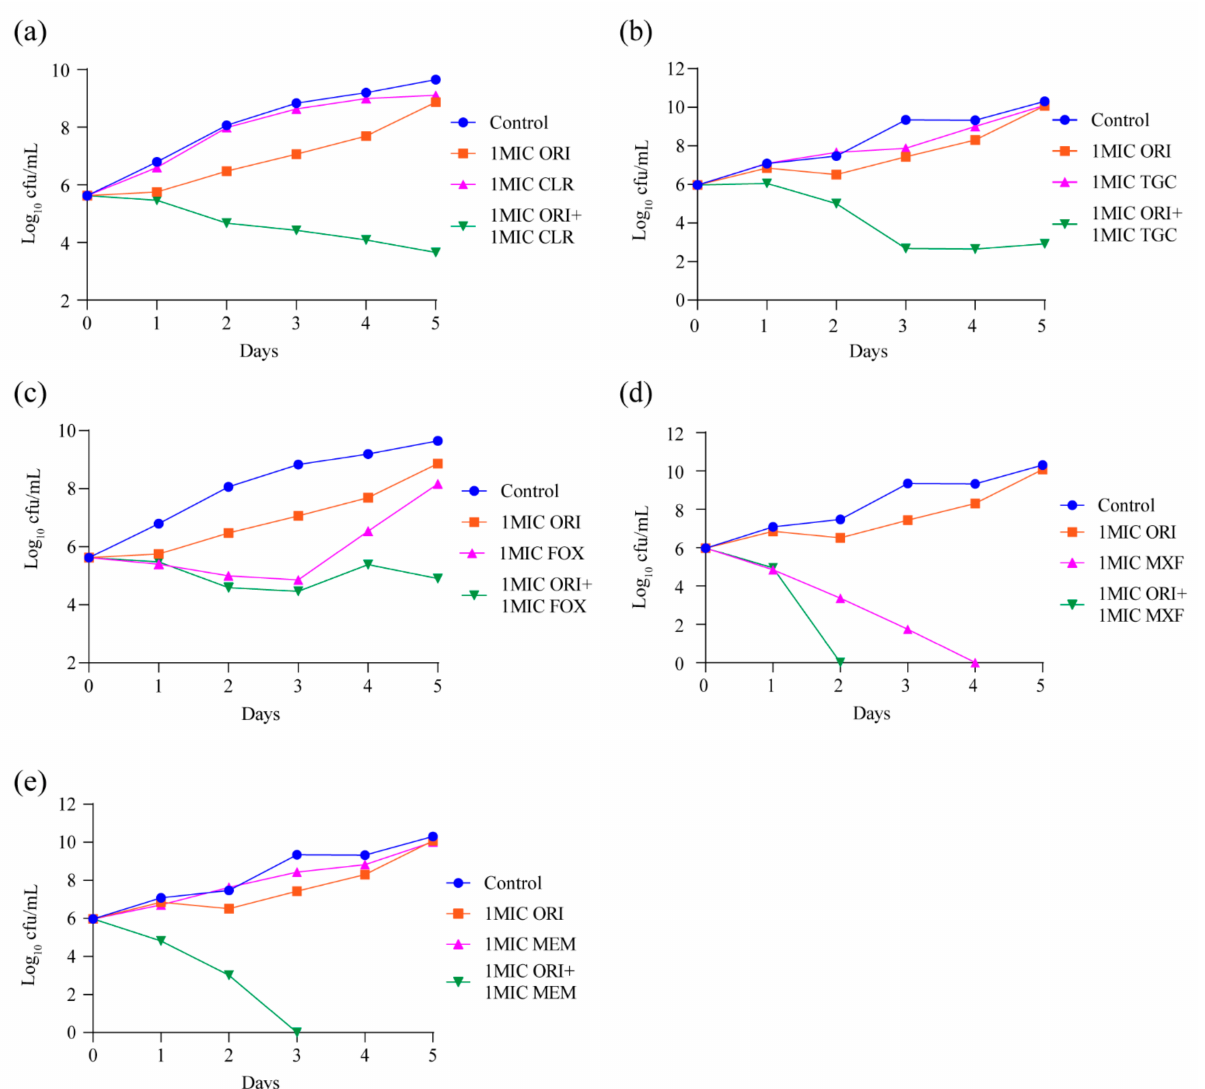
Figure 4. Oritavancin significantly potentiates ( a ) 1 × MIC clarithromycin, ( b ) 1 × MIC tigecycline, ( c ) 1 × MIC cefoxitin, ( d ) 1 × MIC moxifloxacin, and ( e ) 1 × MIC meropenem bactericidal effect against M. abscessus in vitro. Data are represented the mean ± standard deviation (SD) of triplicates for each concentration. The error bar is smaller than the symbol size and not showed. ORI, oritavancin; CLR, clarithromycin; TGC, tigecycline; FOX, cefoxitin; MXF, moxifloxacin; MEM,